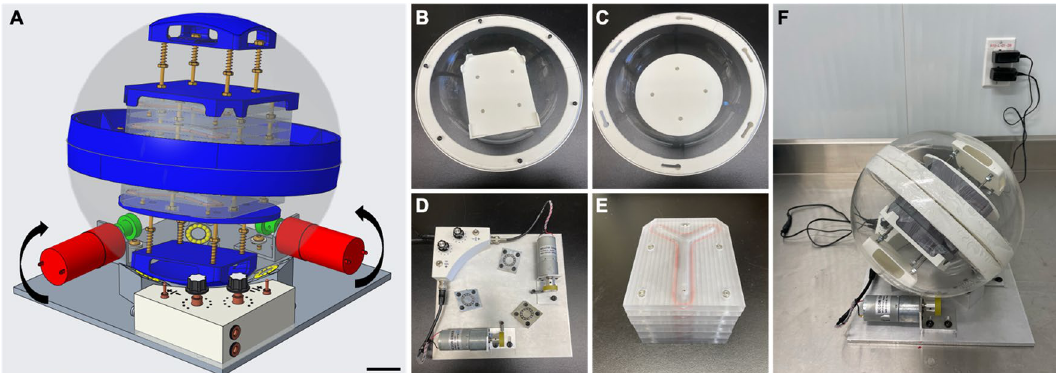
Figure 1. Rotary seeding system. ( A ) Computer-aided design (CAD) of the system with CREO 5.0 software with directional indicators; ( B,C ) photographs of the male and female halves of the acrylic sphere with 3D-printed closure ring and plates to keep the seeding chambers in place; ( D ) aluminum support plate with three ball bearing-type supports, two motors and an electronic control unit; ( E ) five custom-made acrylic cell seeding chambers; ( F ) assembled rotary seeding system. Scale bar = 5